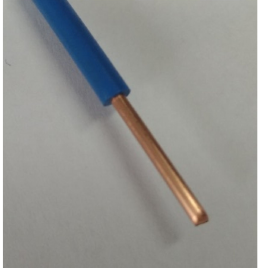
Figure 1. H07V-U insulated electric copper wire.